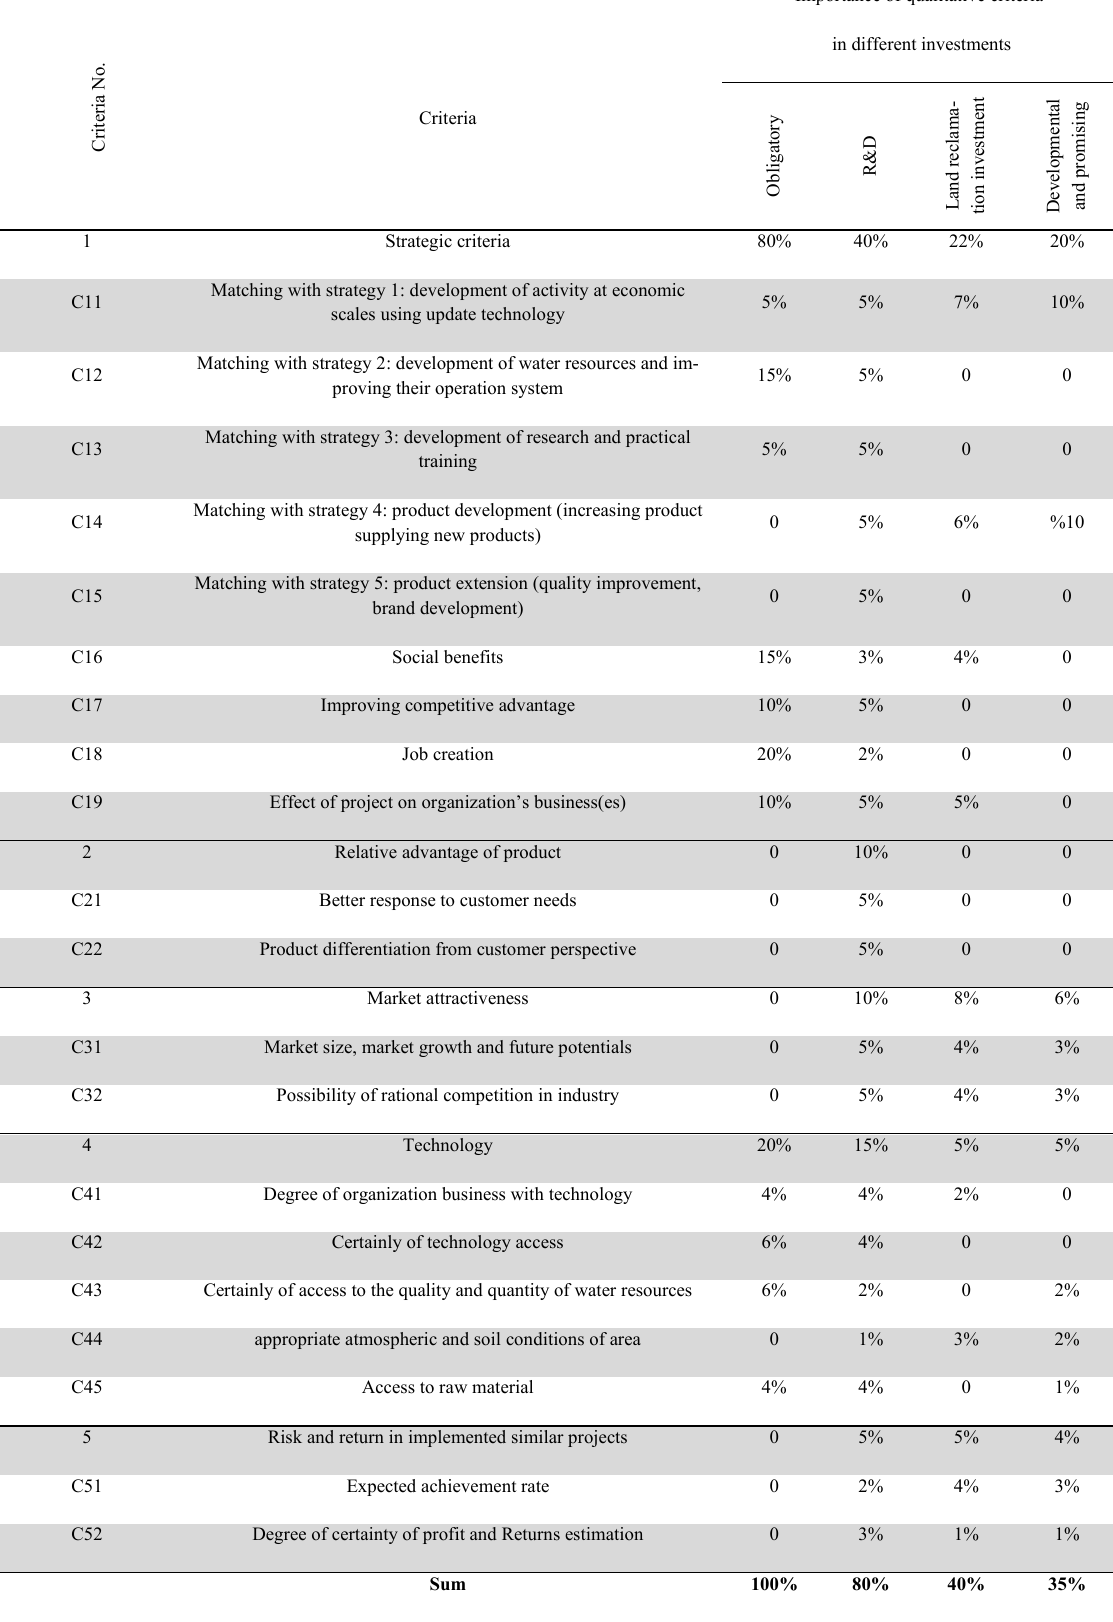
Importance of qualitative